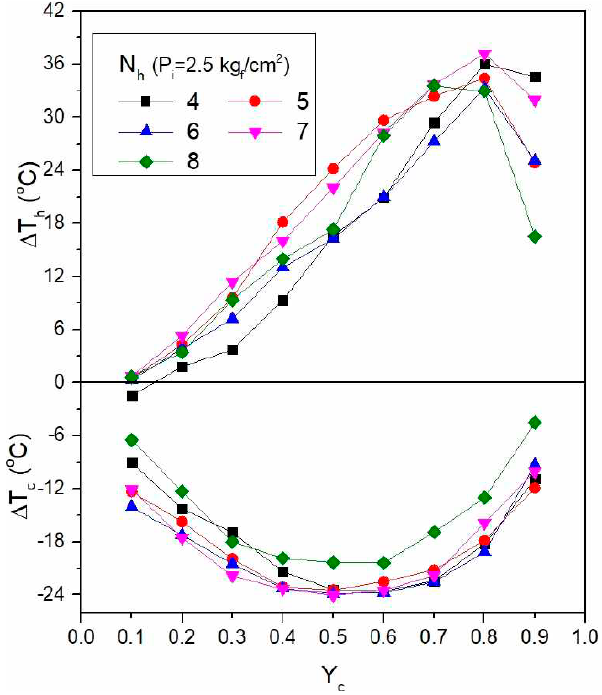
∆ T c according to inlet pressure (P i ) 2.5 kgf h and